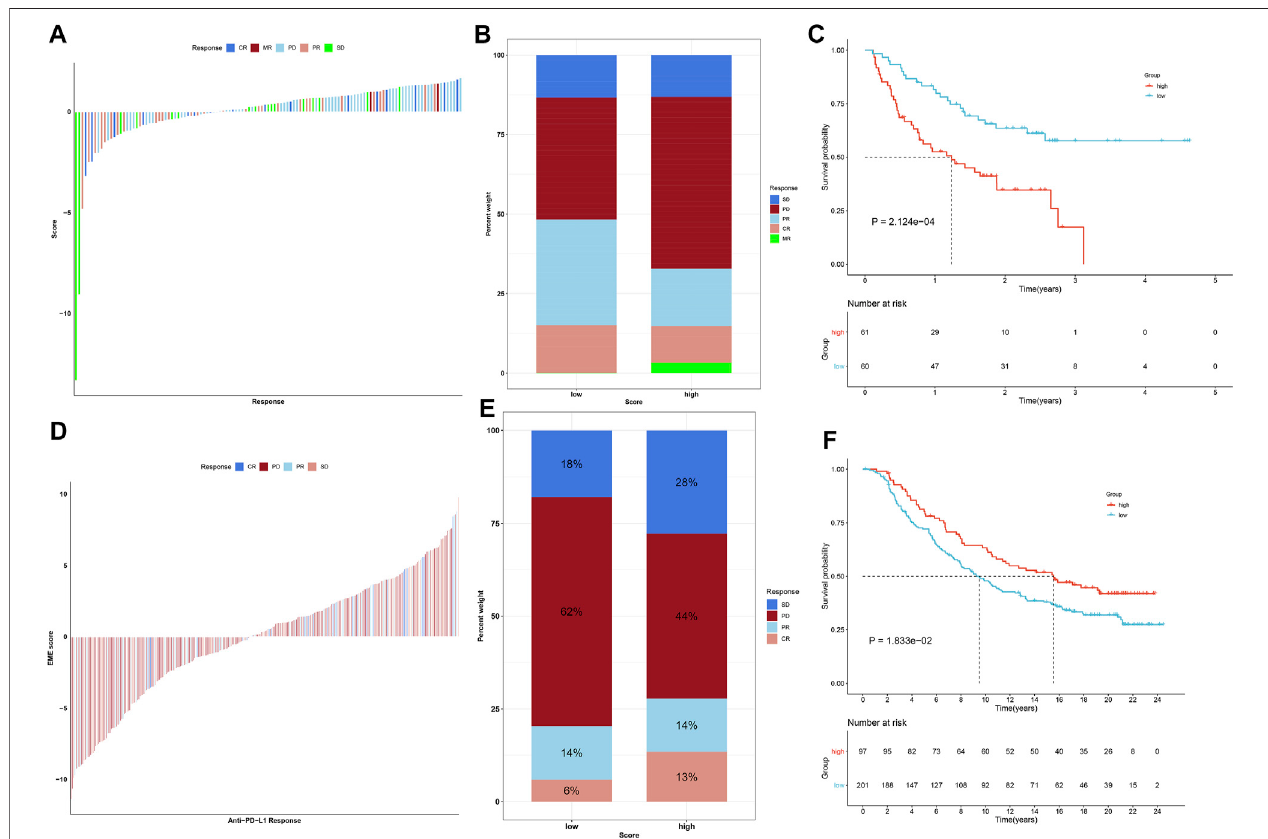
FIGURE7| Thisimmunescoreacts asapredictor ofimmunotherapeutic responses. (A) Landscapeoftherapeuticresponsestoanti – PD-1inhibitor intheLiu etal. cohort. (B) Thefractionsofresponsestoanti – PD-1immunotherapyinhighandlowimmunescoregroupsintheLiuetal.cohort. (C) Kaplan – Meieranalyses forhighand low immune score patients in the Liu et al. cohort. (D) Landscape of therapeutic responses to anti – PD-L1 inhibitor in the IMvigor210 cohort. (E) The fractions of responses to anti – PD-L1 inhibitor in high and low immune score groups in the IMvigor210 cohort. (F) Kaplan – Meier analyses for patients with high or low immune score in the IMvigor210